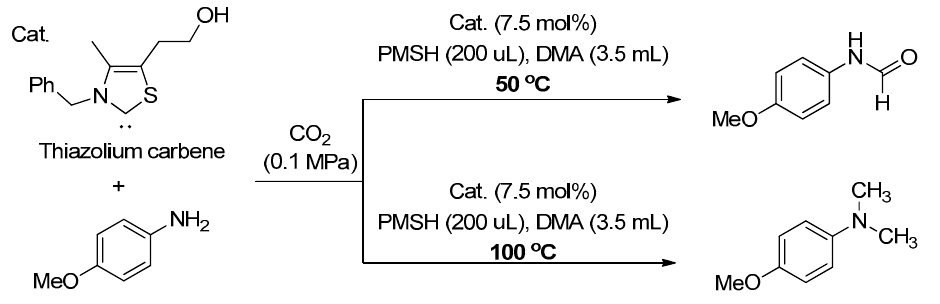
Scheme 23. Thiazolium carbene-based catalyst for N -formylation/ N